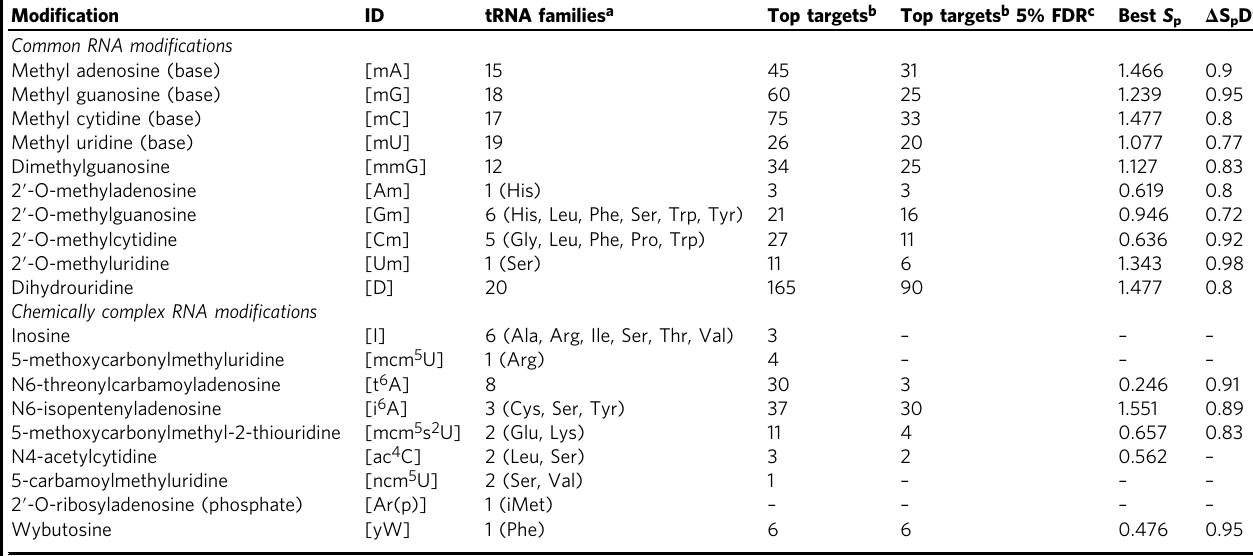
(Supplementary Fig. 7b). Like m 7 G, identi fi ed in the 16S dataset,